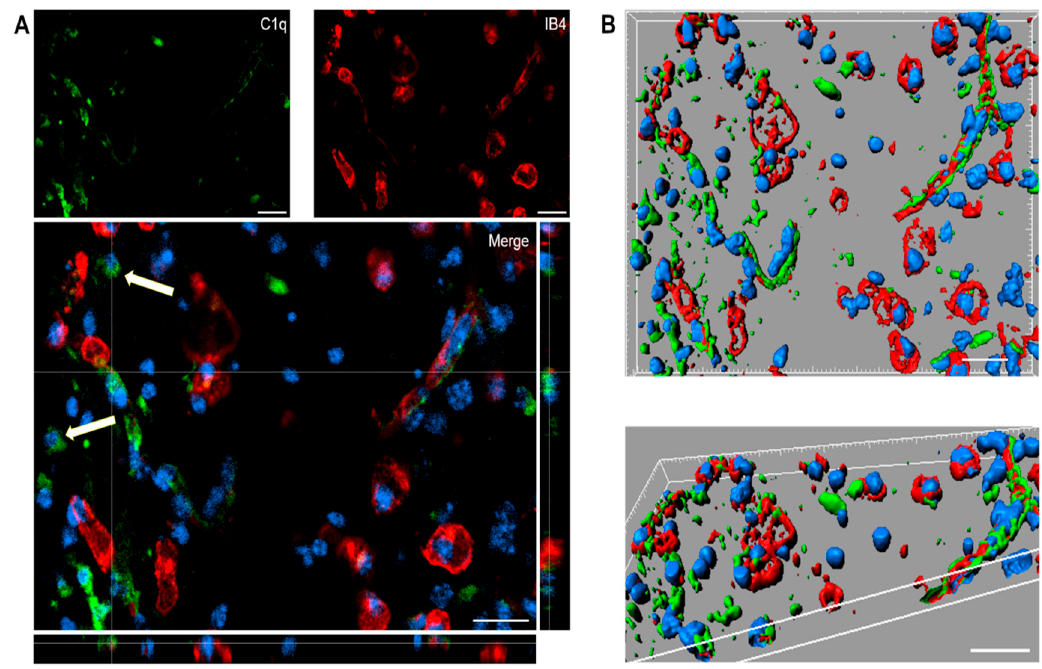
Figure 5. ( A,B ). Confocal analysis of C1q localization in the contused cortex 96 h after TBI. ( A ) C1q (green) is present on brain vessels (IB4, red) and in cell-like structures (arrows). Nuclei are in blue. ( B ) Three-dimensional image rendering shows C1q in vessels. Images are representative of at least two independent experiments. Scale bar = 20 μ m.